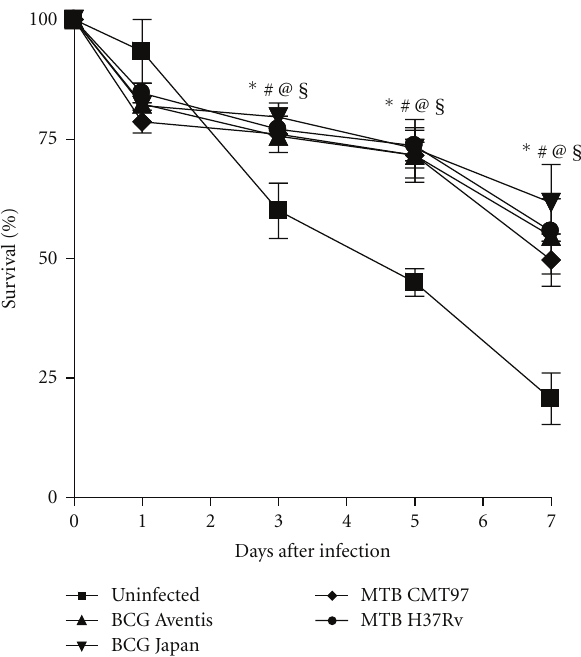
Figure 3: Bacterial loads in DC infected with MTB H37Rv, MTB CMT97, BCG Aventis and BCG Japan. DCs obtained from the same donor were exposed to di ff erent mycobacteria (MOI, 1). After 3h, cells were washed then, part of them was checked for intracellular mycobacteria while the rest were resuspended in fresh medium and left in culture. Total bacterial load was assessed over the first 7 days and it is indicated as fold induction compared to the intracellular bacteria after 1 day from infection. The BCG Japan CFU were found significantly di ff erent at day 7 as compared to MTB H37Rv ( ∗ P < . 01), MTB CMT97 ( ∗ P < . 01) and BCG Aventis ( # P < . 05). Data shown as mean ± SEM from 3 independent experiments performed in triplicates. Statistical significance was assessed by using two-way